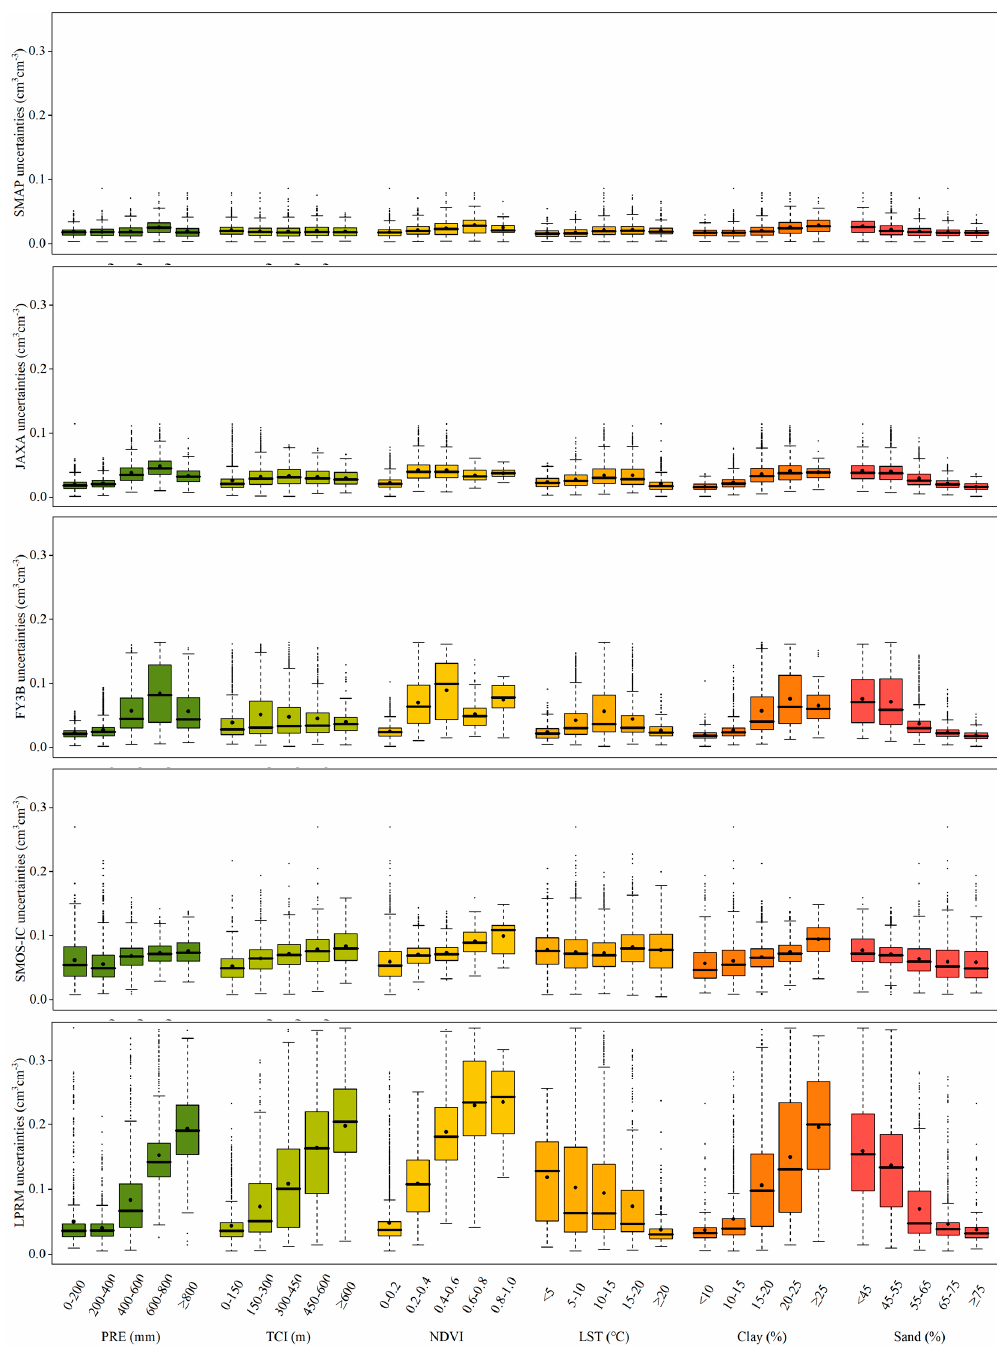
Figure 7. Relationship between the selected variables (that is, PRE, TCI, NDVI, LST, Clay and Sand) and TCH-based uncertainty results. The boxplots show the median (black thick horizontal line), mean (black dot), 25th and 75th percentiles (top and bottom of the colored shaded box, respectively), and outlier ranges (edges of the top and bottom whiskers).